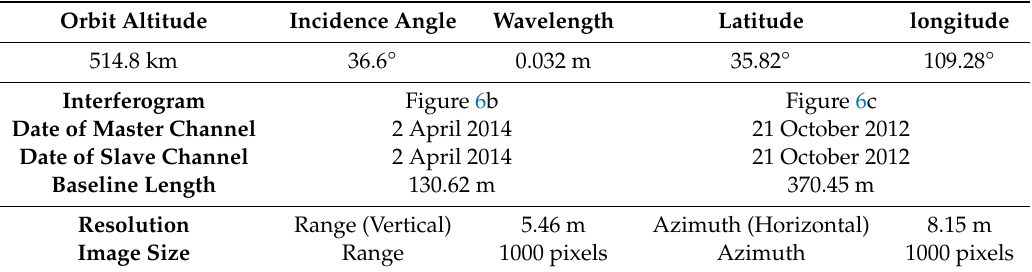
Table 5. Statistical information of PU performance in Figure 6h,i,l,m,p,q. PUMA with potential exponent